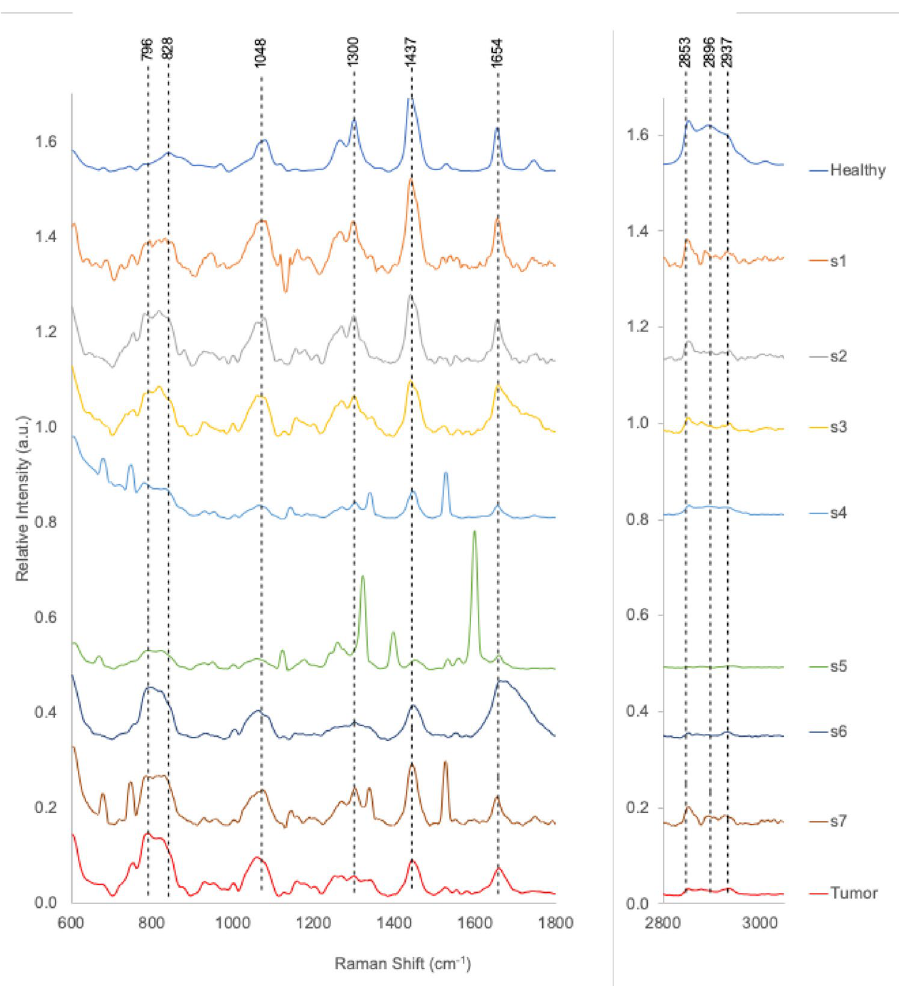
Figure 6. Spectra corresponding to the 7 high V ER targets listed in Table 6. The average spectra from tumor and healthy regions appear at bottom and top of figure, for comparison. All of the 7 spectra show a depletion in signal strength for the three HW bands. The HW NN cancer likelihood probabilities ranged from P Tumor ~ 0.763 to 0.927. s7 produces the lowest HW tumor probability ( P Tumor = 0.763) and highest V ER (~ 0.047) due to the residual signal at 2853 cm −1 . Spectra s5, s6, and s7 triggered a low-level warning in FP ( P Tumor ~ 0.6). These spectra show increases in signal strength at 796 and 828 cm −1 , indicative of cellular increases in nucleic acids and proteins. Spectra s4, s5, and s7 contain narrow peaks of activity expected from surgical marking dyes at locations that do not compromise the nine NN diagnostic